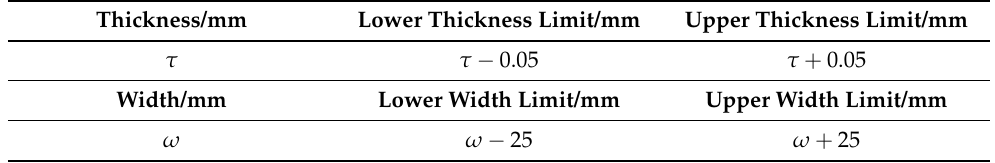
Table 2. Specification range